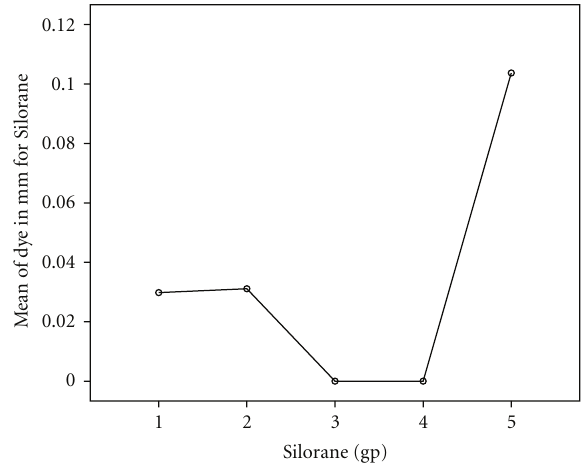
Figure 4: Result of Bonferroni test for the di ff erence between cavity configuration groups for the Silorane adhesive bond.